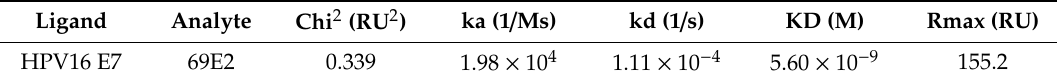
Table 1. A ffi nity measurement of HPV16 E7 to